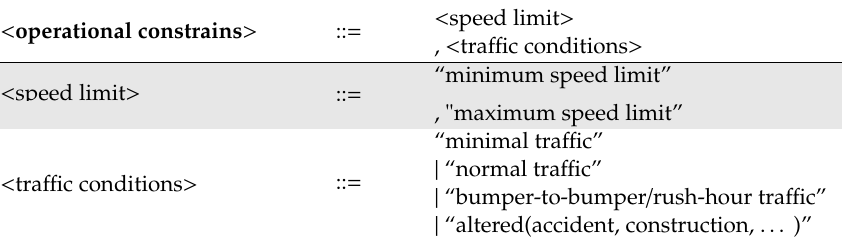
Table A6. The 3rd stage of < environment >< operational constrains > .